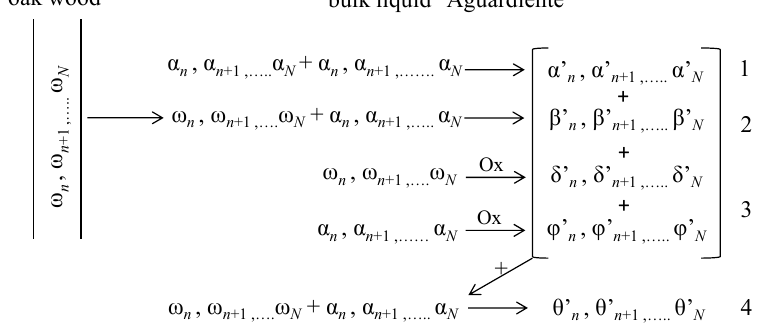
Figure 1. Reduced scheme of the main reactions in the rum ageing process. α , ω represent the original compounds of Aguardiente and wood, correspondently, and α ’, β ’, δ ’, φ ’, θ ’ the probable obtained compounds; ” n ” represents the different types of organic compounds involved in each possible particular reaction. (1) Reaction between the different original compounds in the Aguardiente; (2) substance extraction from the oak wood to the alcoholic bulk liquid; (3) oxidation of both kinds of compounds (extracted and original compounds); (4) new reactions between the original, extracted and the oxidized compounds.